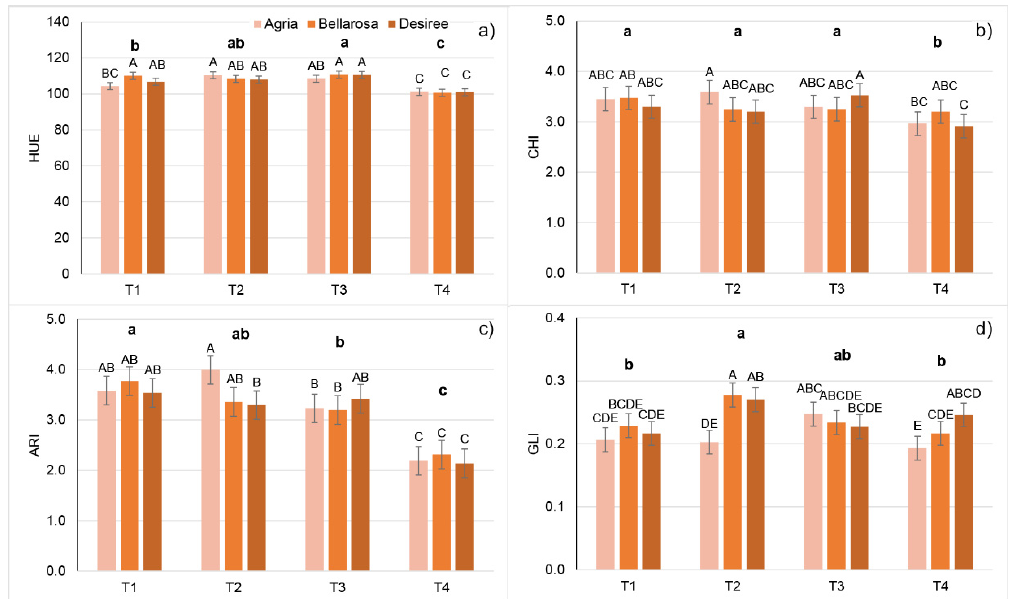
Figure 3. Mean values and double standard error of the mean for the multispectral traits: ( a ) hue (HUE), ( b ) chlorophyll index (CHI), ( c ) anthocyanin index (ARI), and ( d ) green leaf index (GLI) of potato cultivars (Agria, Bellarosa, and Desiree) after ten days of growth in four different temperature treatments: 20/15 °C (T1), 25/20 °C (T2), 30/25 °C (T3), and 35/30 °C (T4). Different uppercase letters indicate significant differences for cultivar × treatment interaction; different lowercase letters in bold indicate significant differences between temperature treatments (Tukey’s HSD test p < 0.05).